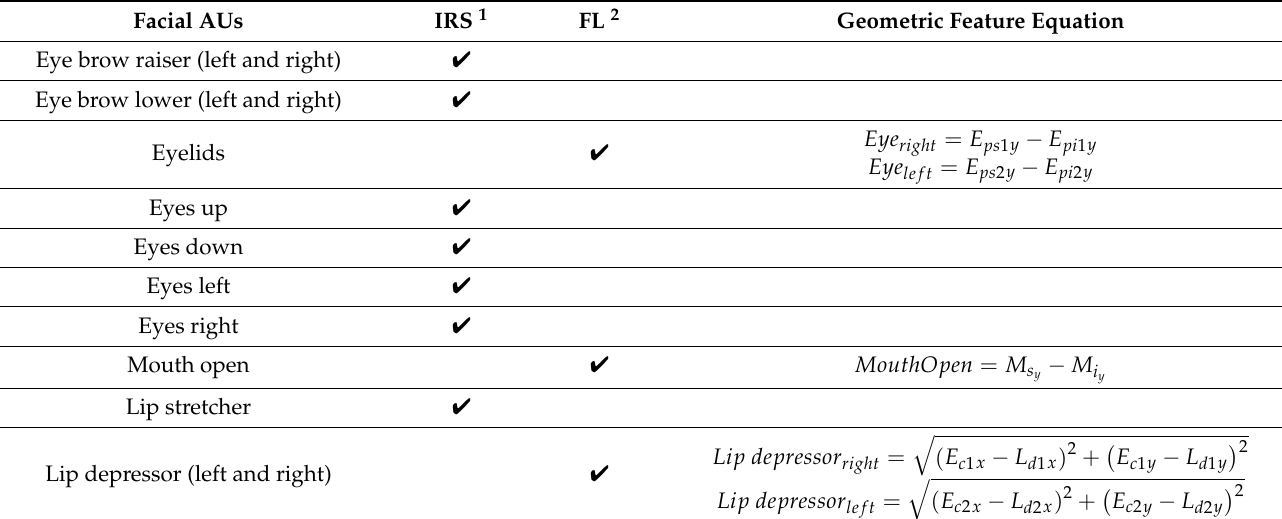
Table 2. Selected Facial AUs used in this work, provided by the Intel ® RealSense™ SDK and the ones obtained through facial landmarks (geometric